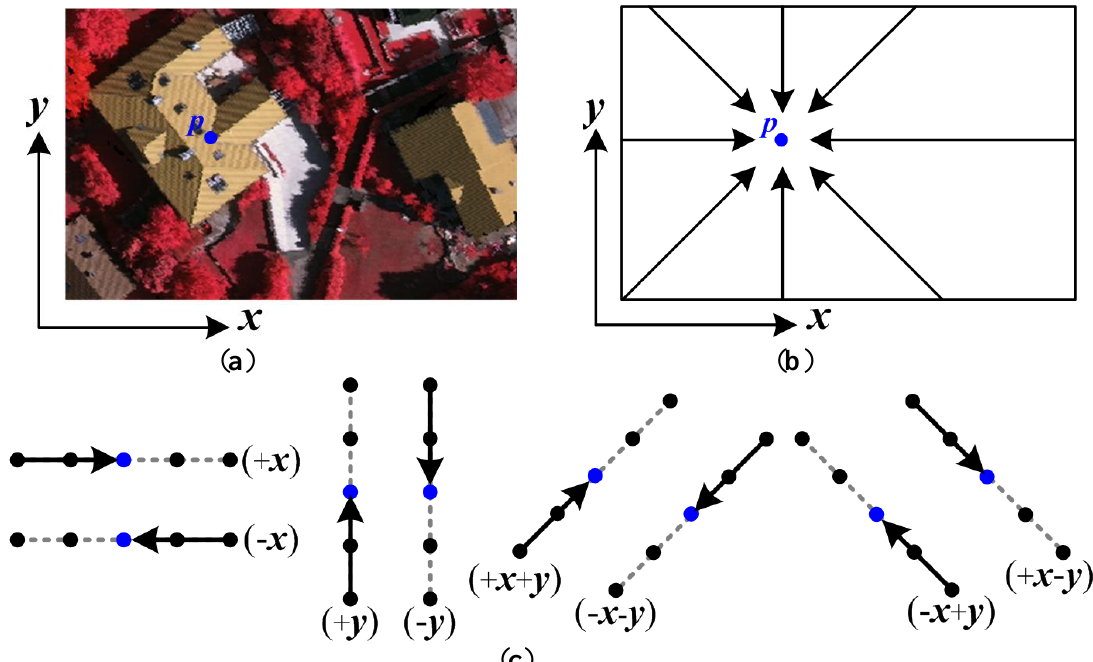
Figure 2. Optimization directions: ( a ) a regular grid grayed by the corresponding image; ( b ) and ( c ) eight optimization directions used in